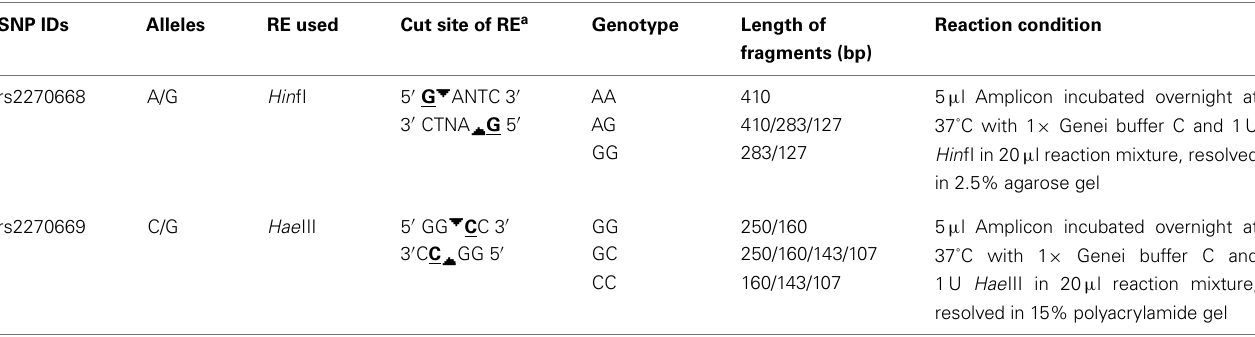
Table 1 | Details of restriction fragment length polymorphism analysis.